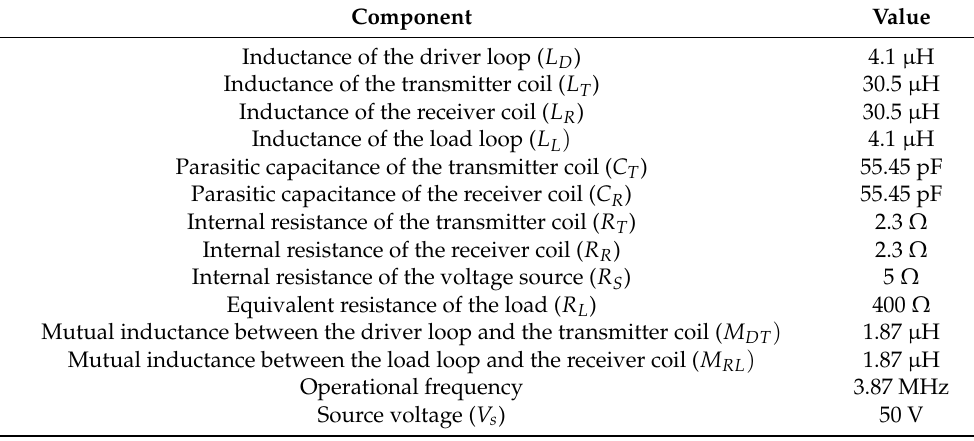
Table 1. Features of the SCMR system used for the